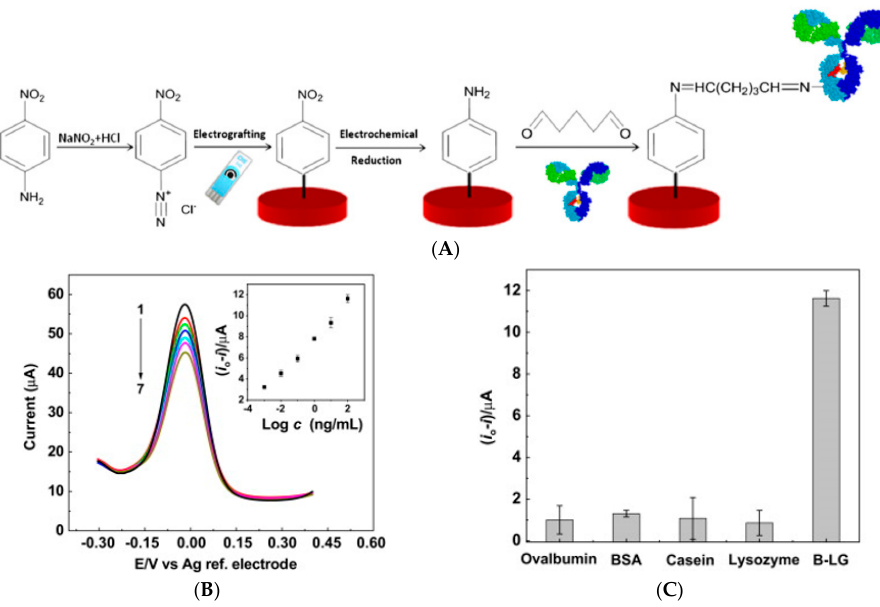
Figure 9. ( A ) Electroreduction of a diazonium salt on a SPE, for covalent immobilization of β -lactoglobulin antibodies; ( B ) DPVs of the immunosensor incubated with different concentrations of β -lactoglobulin (inset: calibration curve); ( C ) Comparison of the DPV response of the graphene-modified electrodes to 1000 ng mL − 1 ovalbumin, BSA, casein, lysozyme, and 100 ng mL − 1 β -lactoglobulin. Reprinted from [52], Copyright 2012, with permission from